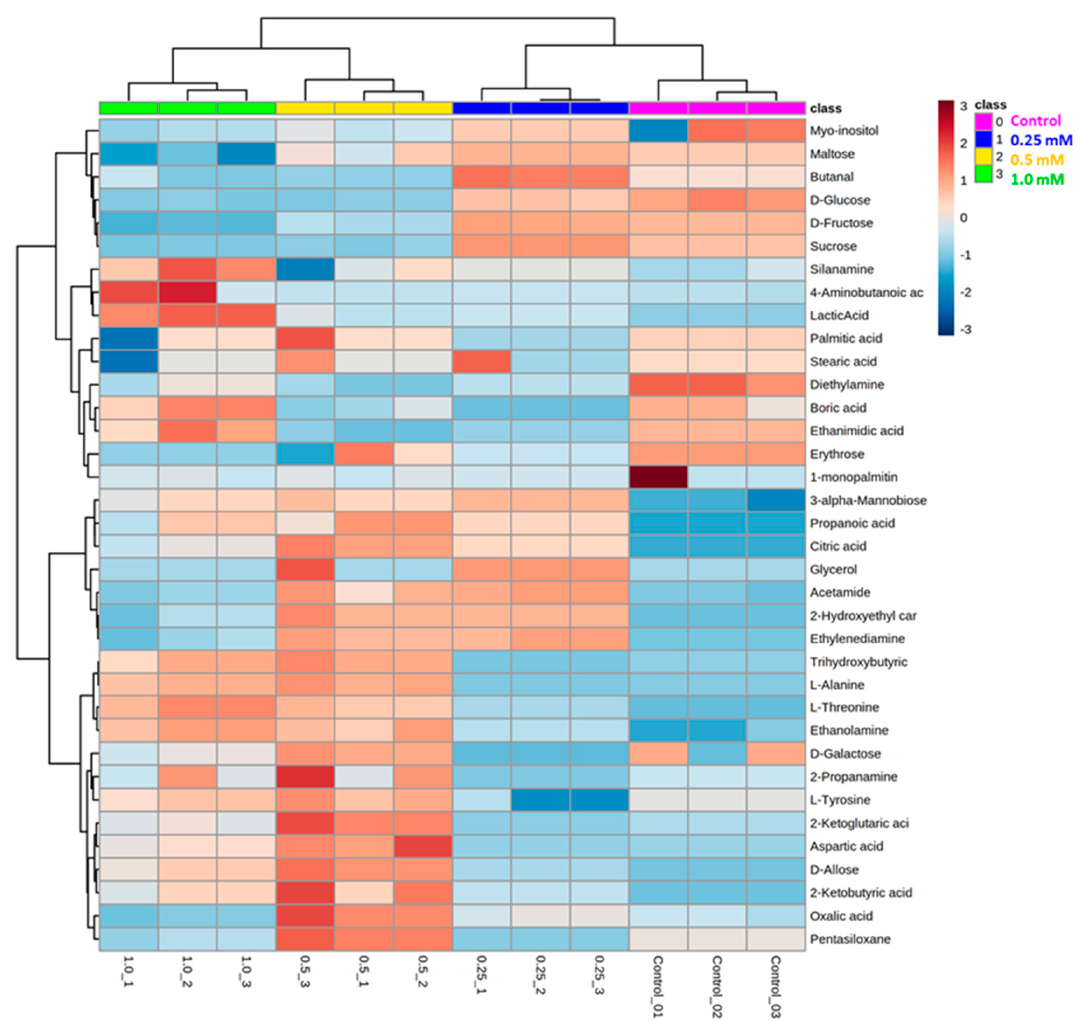
Figure 8. Heatmap illustration of quantities of commonly found metabolites in A. thaliana after0.25 mM, 0.5 mM and 1.0 mM rohitukine treatments as compared to controls. The colour intensities of each box represent the level of each metabolite in each rohitukine-treated group.